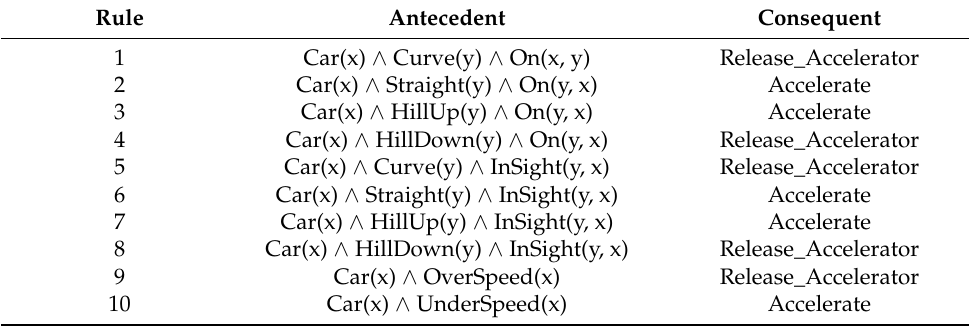
Table 1. Rule set for “normal” use of the accelerator in different road situations.